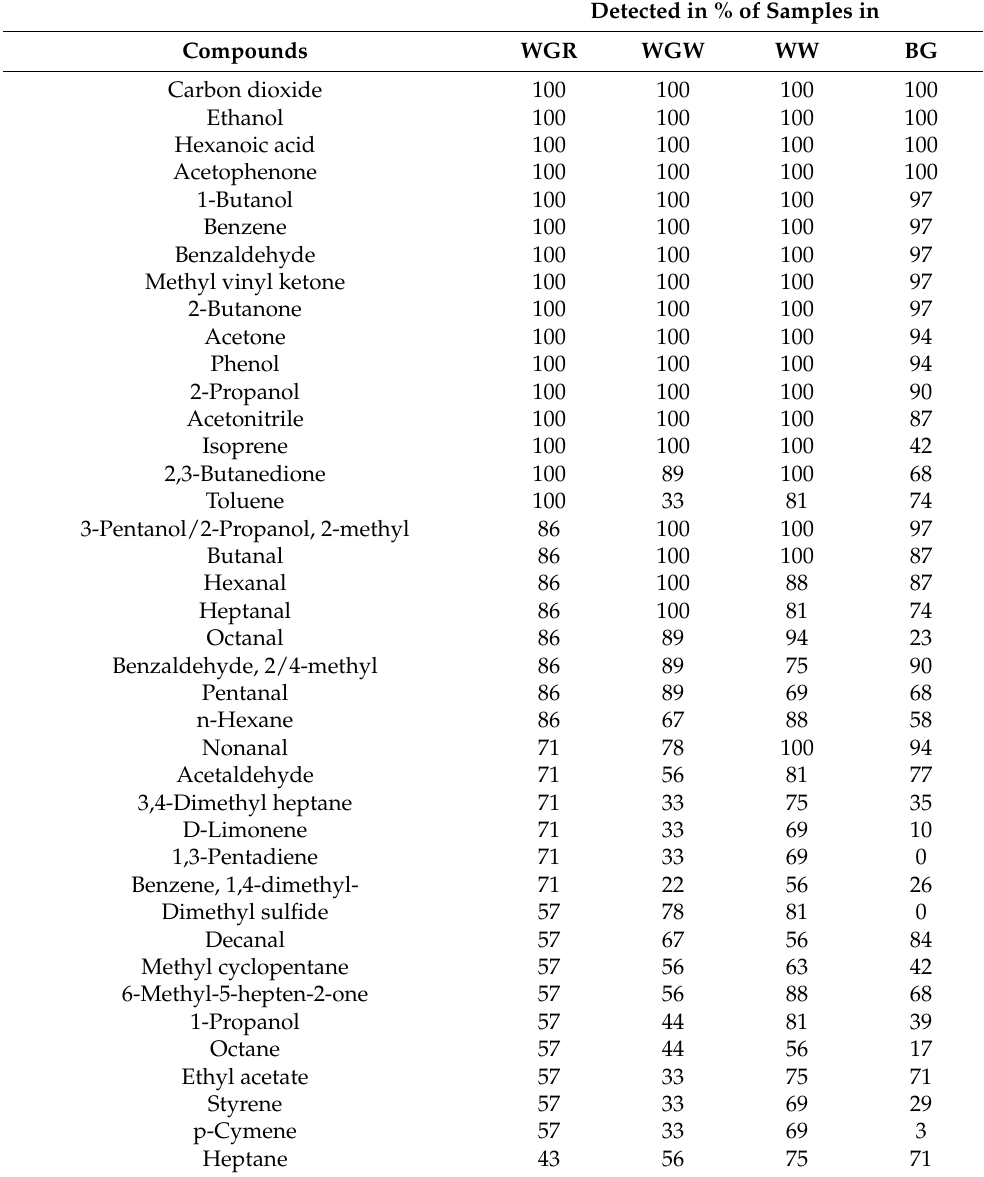
Table 1. Common 1 volatile compounds in the exhaled breath samples collected from the study participants after the diet periods and their presence in the background room air